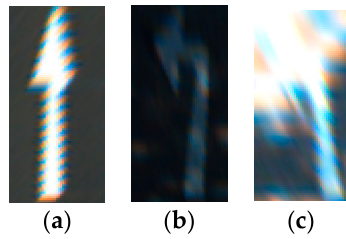
Figure 14. Examples of incorrect recognition cases: ( a ) FA is incorrectly recognized into FLA; and ( b , c ) LA is incorrectly recognized into RA.